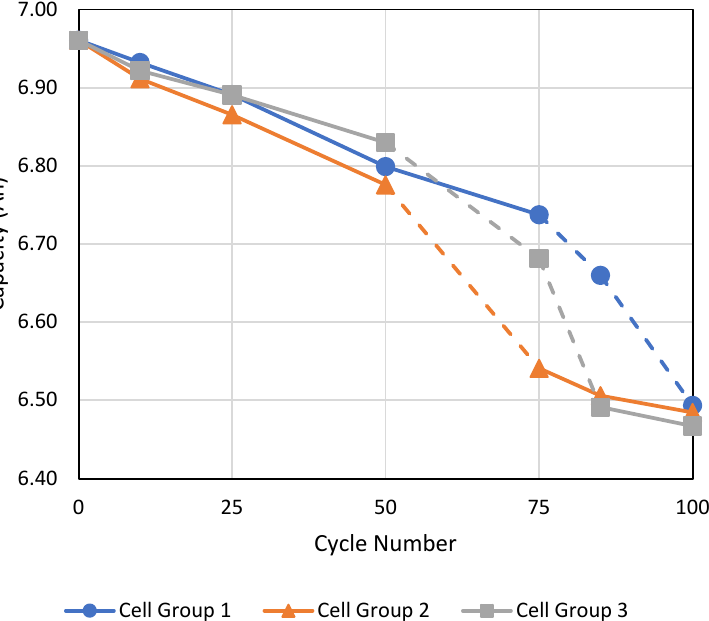
Figure 4. Capacity degradation of cell groups with thermal control applied (solid lines represent active cooling, and dashed lines denote no active cooling). Discharge rate of 5C, charge rate of 3C throughout cycling.